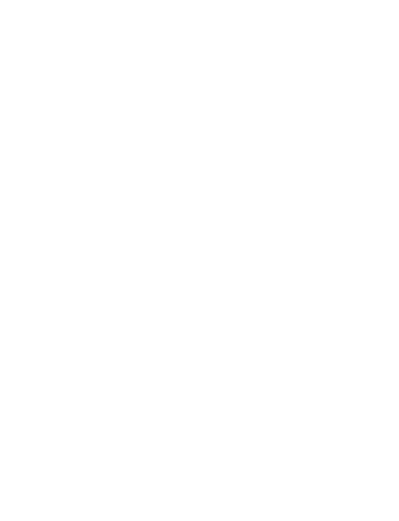
Table 1. The characteristic components of